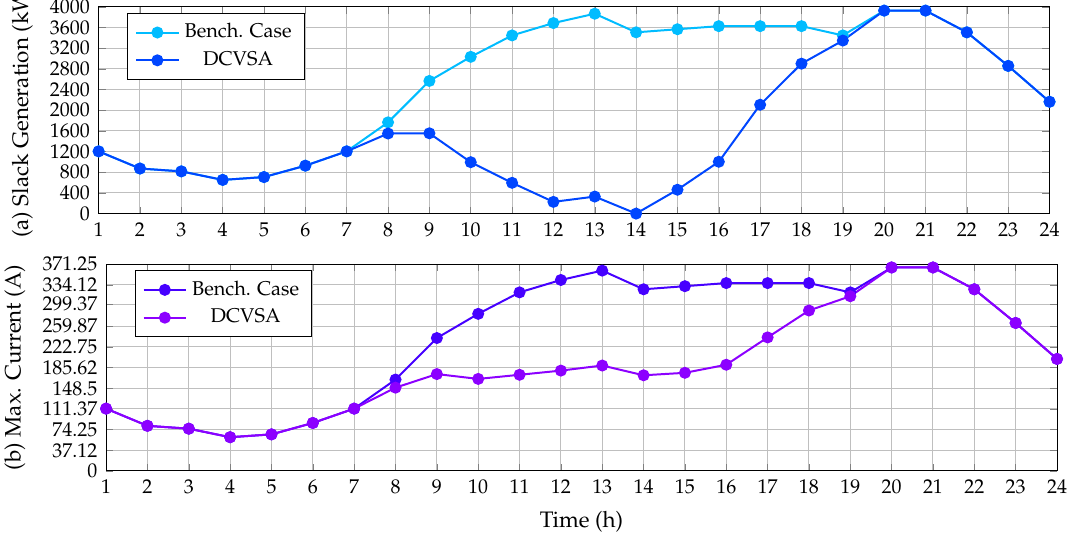
Figure 5. Impact of the PV inclusion in the IEEE 33-bus system: ( a ) power injections in the slack source, and ( b ) maximum current